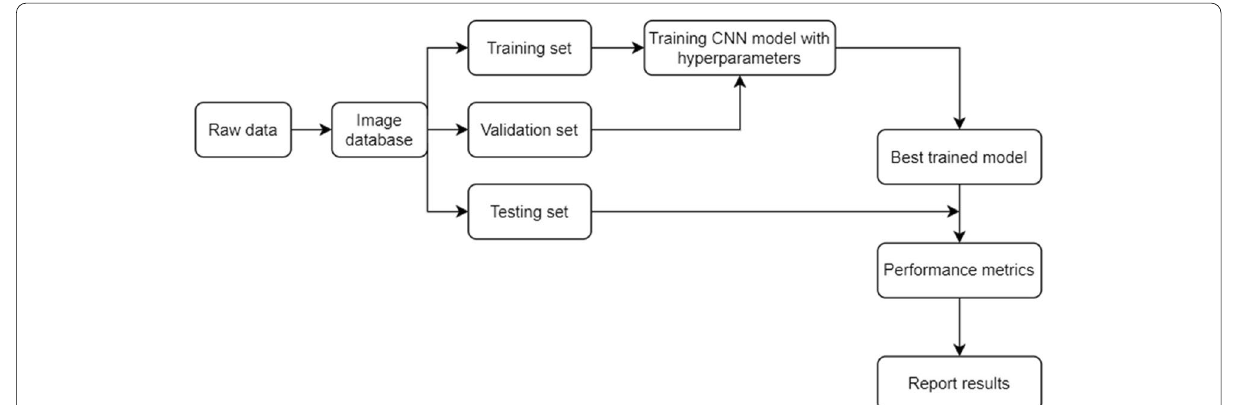
Fig. 3 The flowchart of the proposed CNN-MIAD method